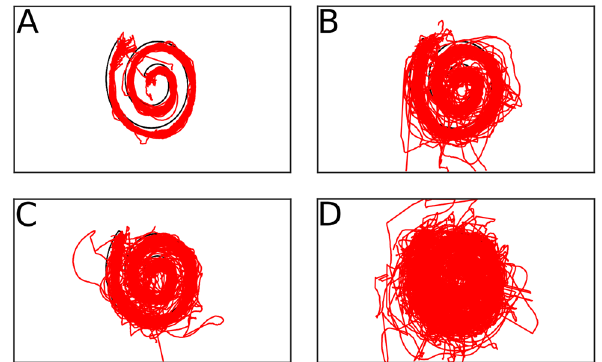
Figure 4. The virtual pens 2D-position on the canvas. The lines participants drew during trials with the spiral shape as a target are shown in red, and the target shape is shown as a black outline for comparison. ( A )–( D ) show trials depending on their condition: Ctrl ( A ), translation ( B ), BCI-simulation ( C ) and T + R ( D